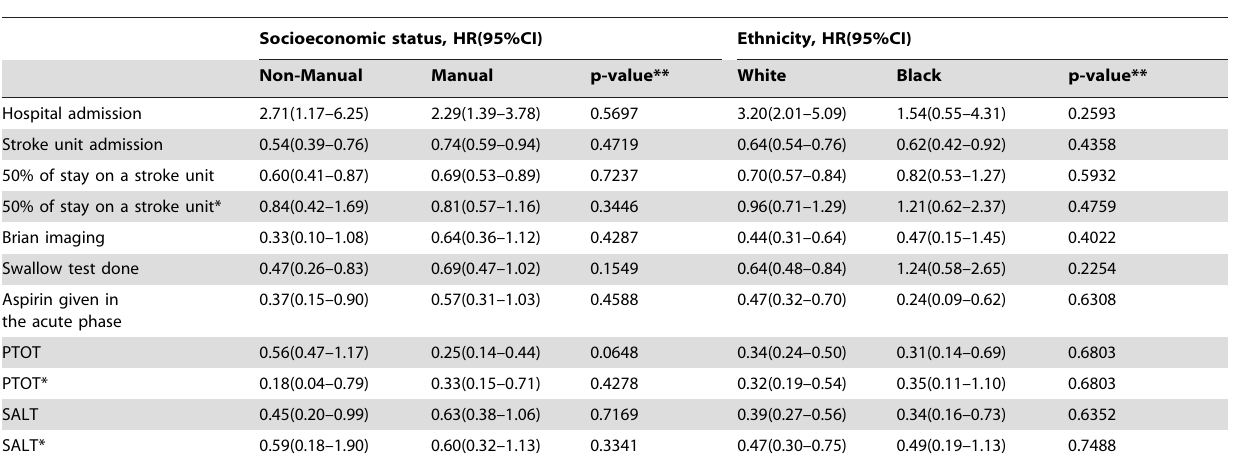
Table 4. Relative hazard of death following receipt of acute care interventions by socioeconomic status and ethnicity.